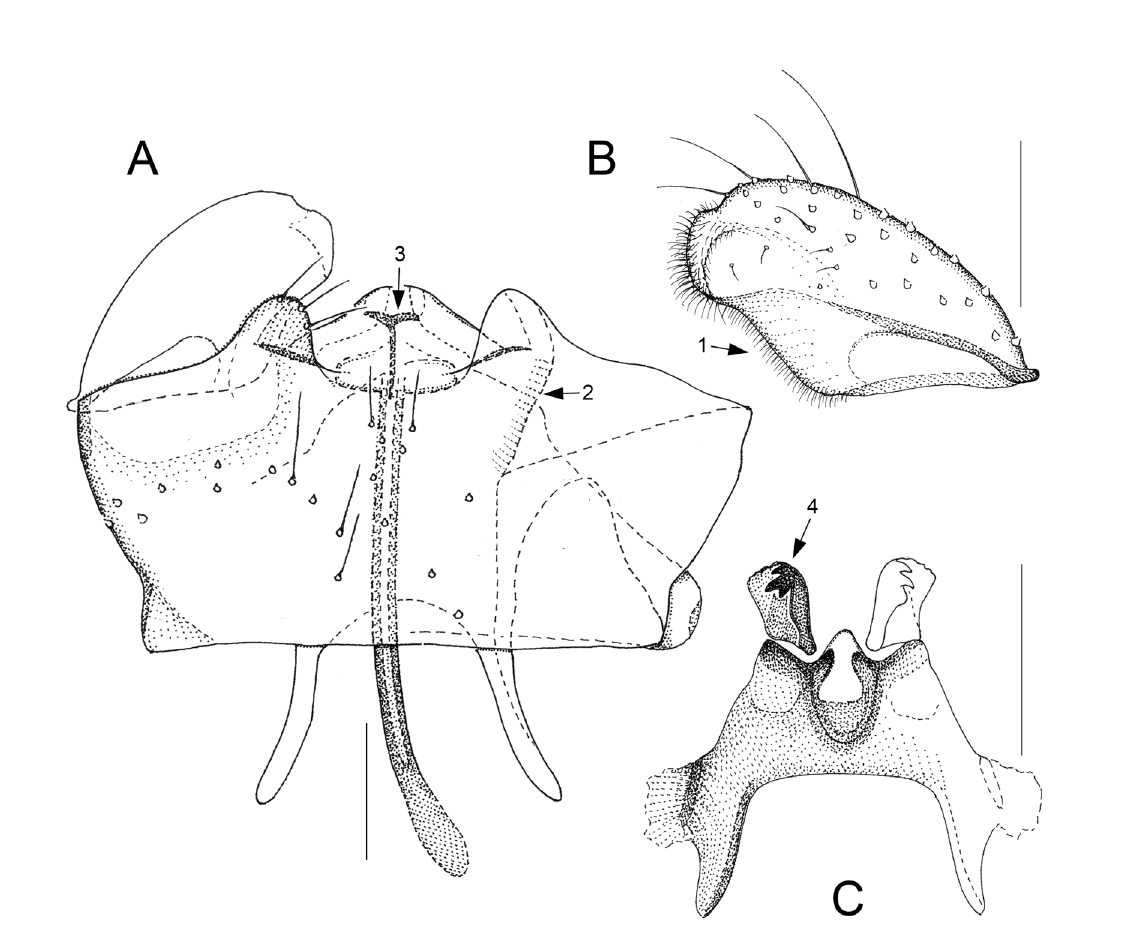
Fig. 9. Glemparon nativitas sp. nov., holotype, ♂ (NZAC, no. CEC1421). A . Genitalia, ventral. B . Gonostylus, ventral. C . Tegmen, ventral. Scale bars = 0.05 mm. Numbered arrows indicate diagnostic characters (see